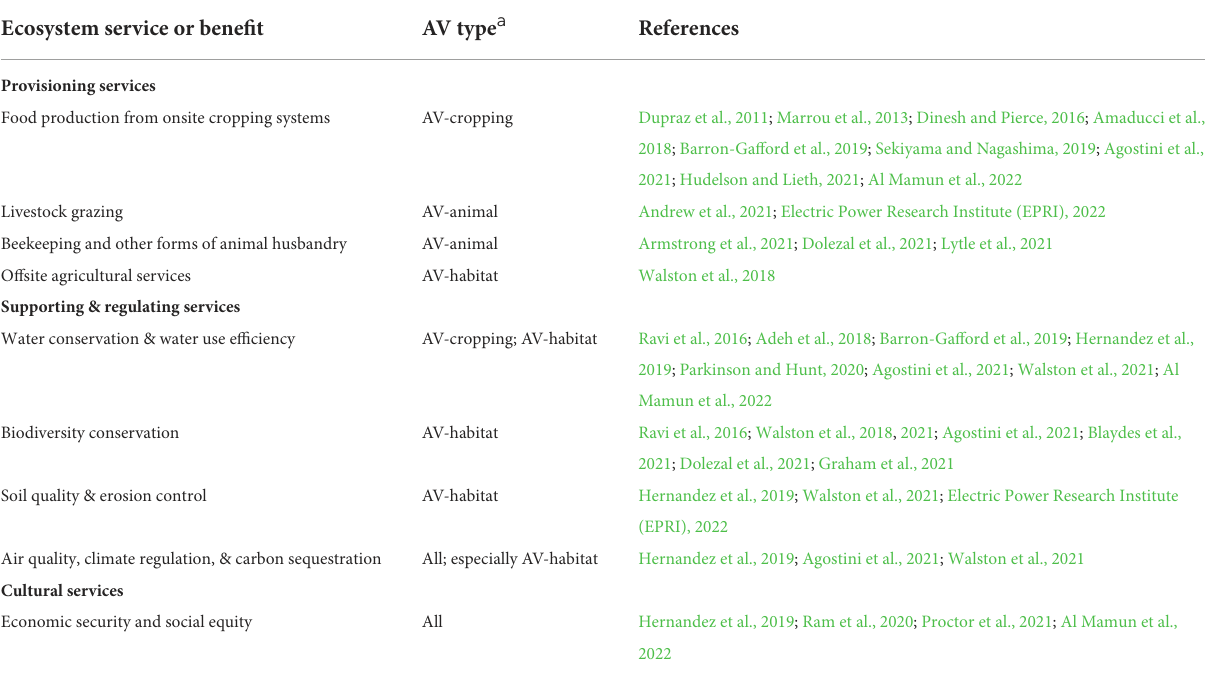
TABLE 1 Ecosystem services of agrivoltaic